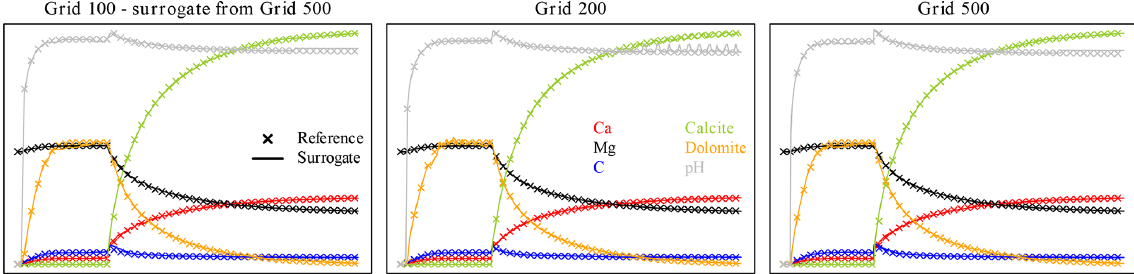
Figure 13. Variable profiles after 60000s (simulation time) for grids 100, 200, and 500. The axes are the same as in Fig. 2.